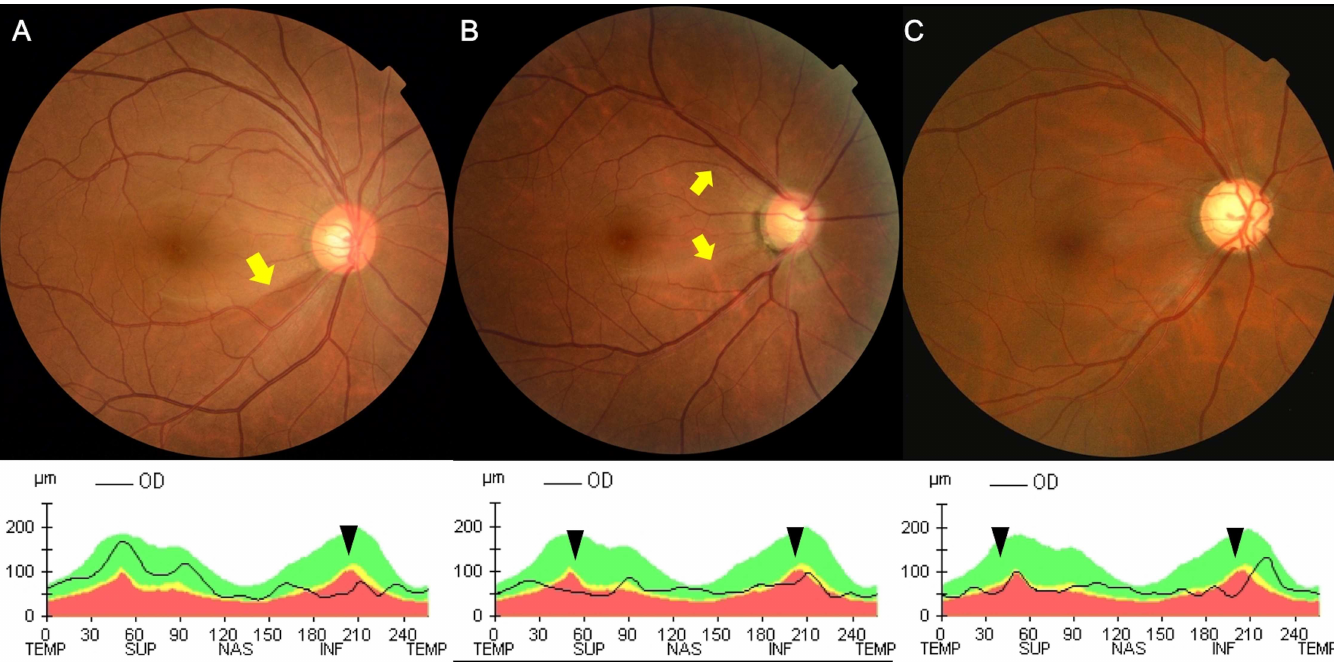
Fig 1. Fundus photographs and optical coherence tomography of representative patients in each group. (A) In a patient with hemi-optic neuropathy, an inferotemporal defect in the retinal nerve fiber layer (RNFL) was evident on fundus photographyand inferior thinningof the RNFL was apparenton the peripapillary RNFL thickness profile obtainedusing Cirrus HD opticalcoherence tomographyOCT. (B) In a patient with bi-optic neuropathy, both superior and inferior RNFL defects were visible on fundus photography, and both RNFL thinningswere confirmed by OCT. The temporal marginsof the RNFL defects evident on the fundus photographs of the abovetwo patients, (A) and (B), are arrowed in yellow. (C) In another patient with bi-optic neuropathy,a diffuse RNFL defect was evidenton fundus photography and a corresponding regionof diffuse RNFL thinningwas apparenton OCT. RNFL thinningbased on OCT in the abovethree patients is indicatedby black